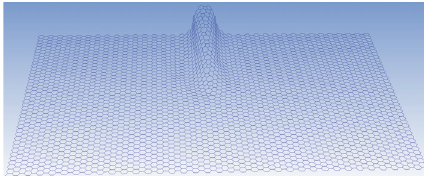
Figure 21: Wireframe display for macromolecular nanomaterials.